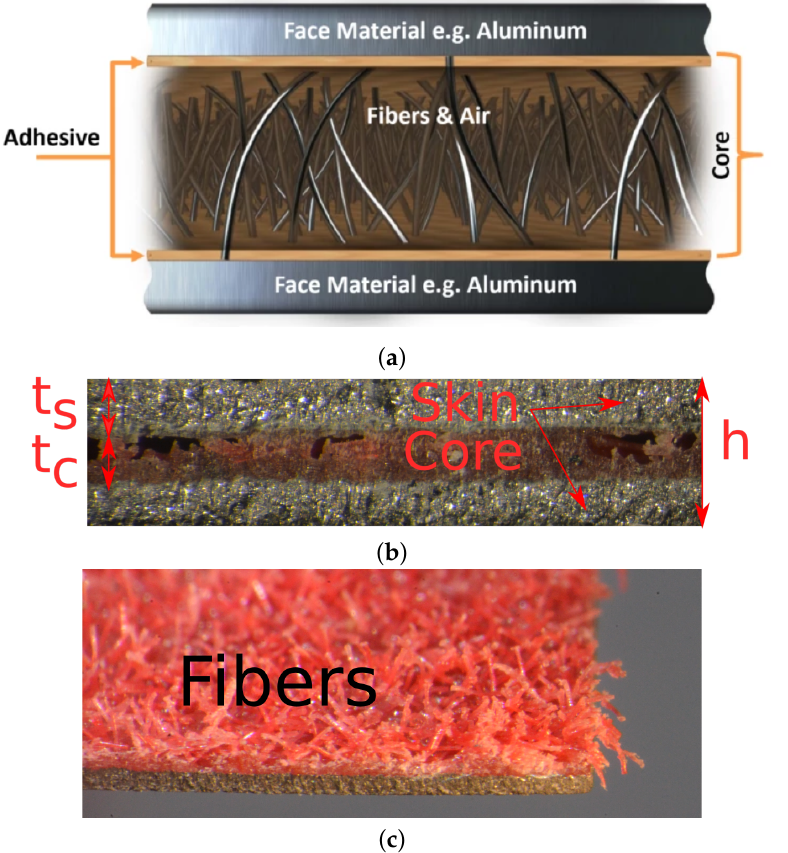
Figure 1. ( a ) Conceptual description of the Hybrix TM sandwich and its constituents; ( b ) microscopic photograph of Hybrix TM with a skin and core thickness of 0.3 mm and 0.6 mm, respectively; and ( c ) fibrous core is presented after the removal of the upper